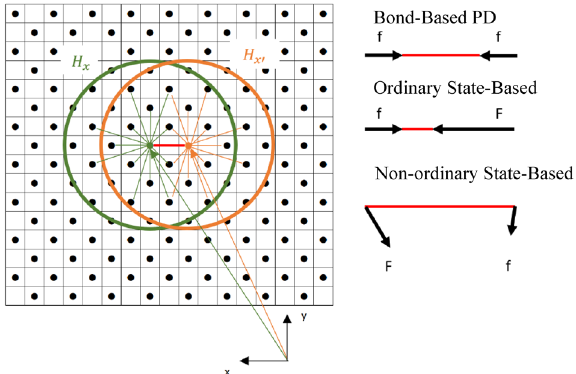
Figure 1. An illustration of PD theory (left). The illustrations of bond interactions in accordance to different Peridynamic theories